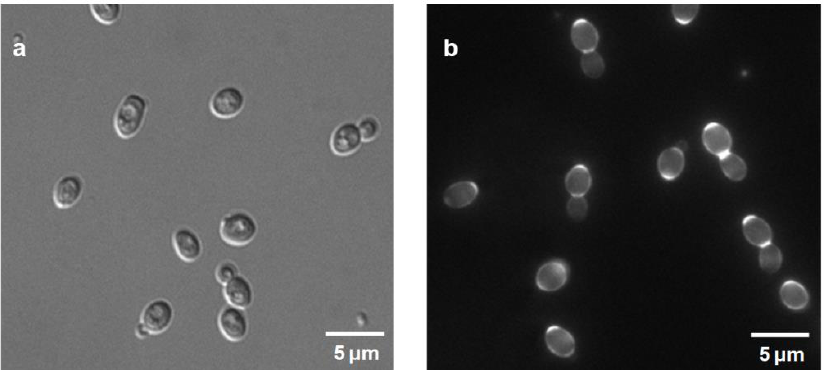
Figure 2. S. bacillaris cell morphology. Cellular morphology of C. zemplinina (syn., S. bacillaris ) strain CBS 9494 as observed under differential interference contrast (DIC) microscopy ( a ) or fluorescence (i.e., calcofluor-white staining) microscopy, which highlights cell walls and budding scars ( b ). Images were obtained using a Leica DMI8 inverted microscope and 63× objective.